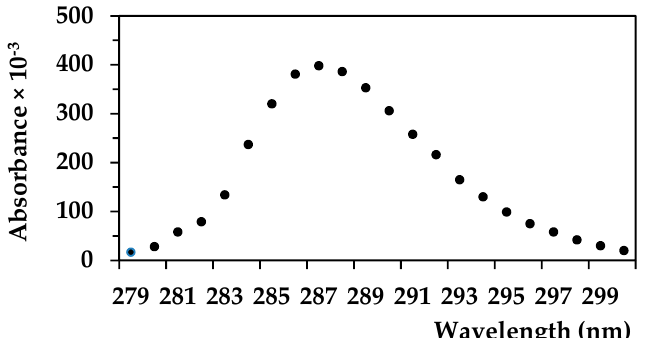
Figure 2. Absorbances of caffeine at selected wavelengths (nm), n = 3.